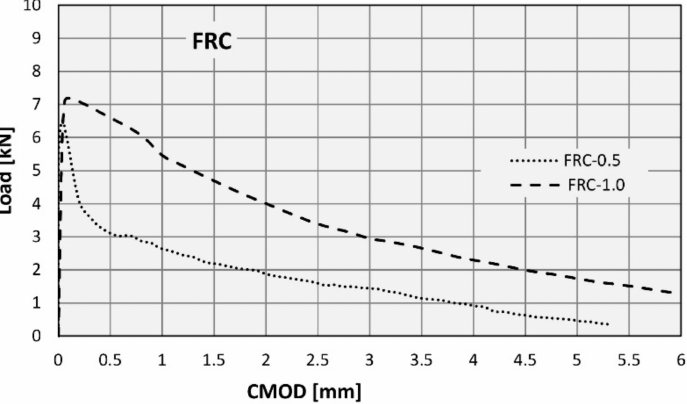
Figure 13. The load-CMOD relationship determined with the use of DIC.